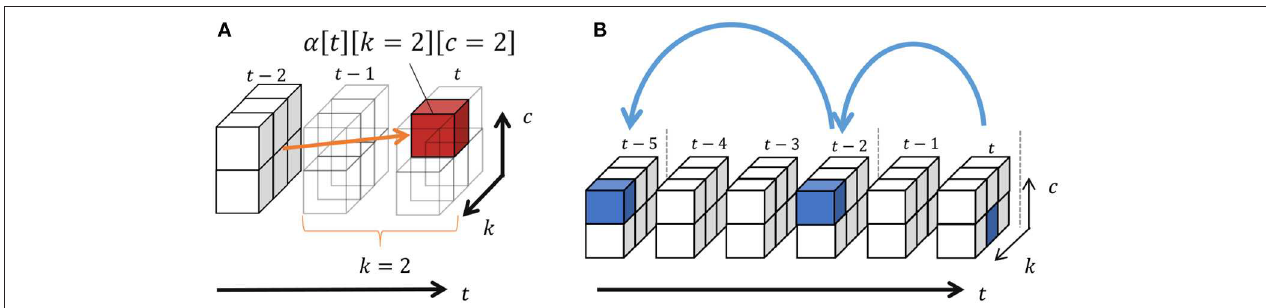
FIGURE 8 | (A,B) Forward filtering–backward